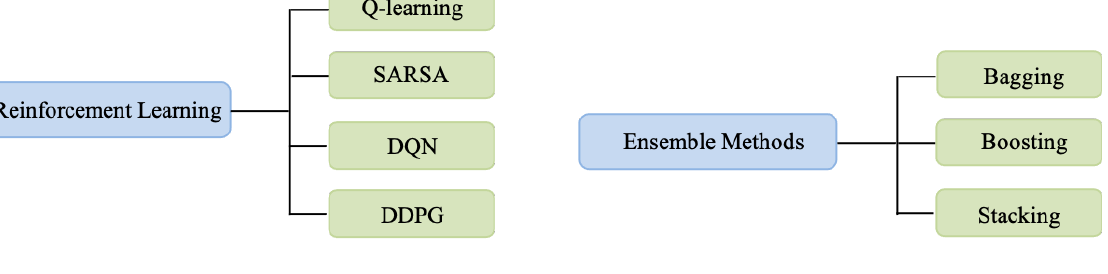
Figure 4. RL and ensemble methods.